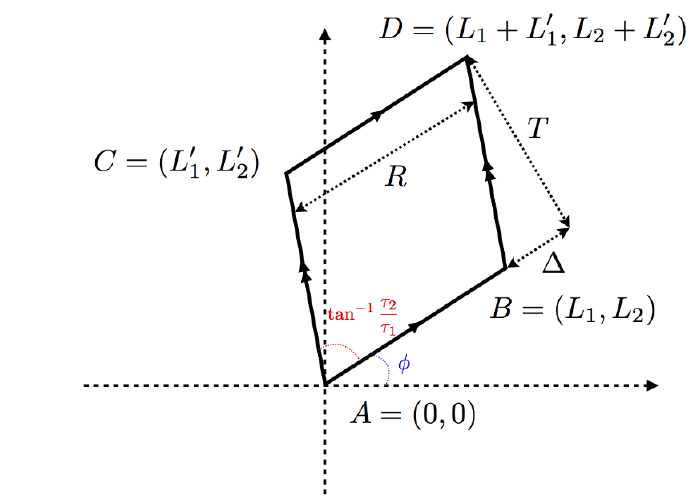
Figure 1 . A torus can be represented as a parallelogram with identi(cid:12)ed opposite sides. Its angle is determined by modular parameters, ] BAC = arctan (cid:28) 2 parallelogram is determined by the angle (cid:30) , which does not a(cid:11)ect the internal geometry of the